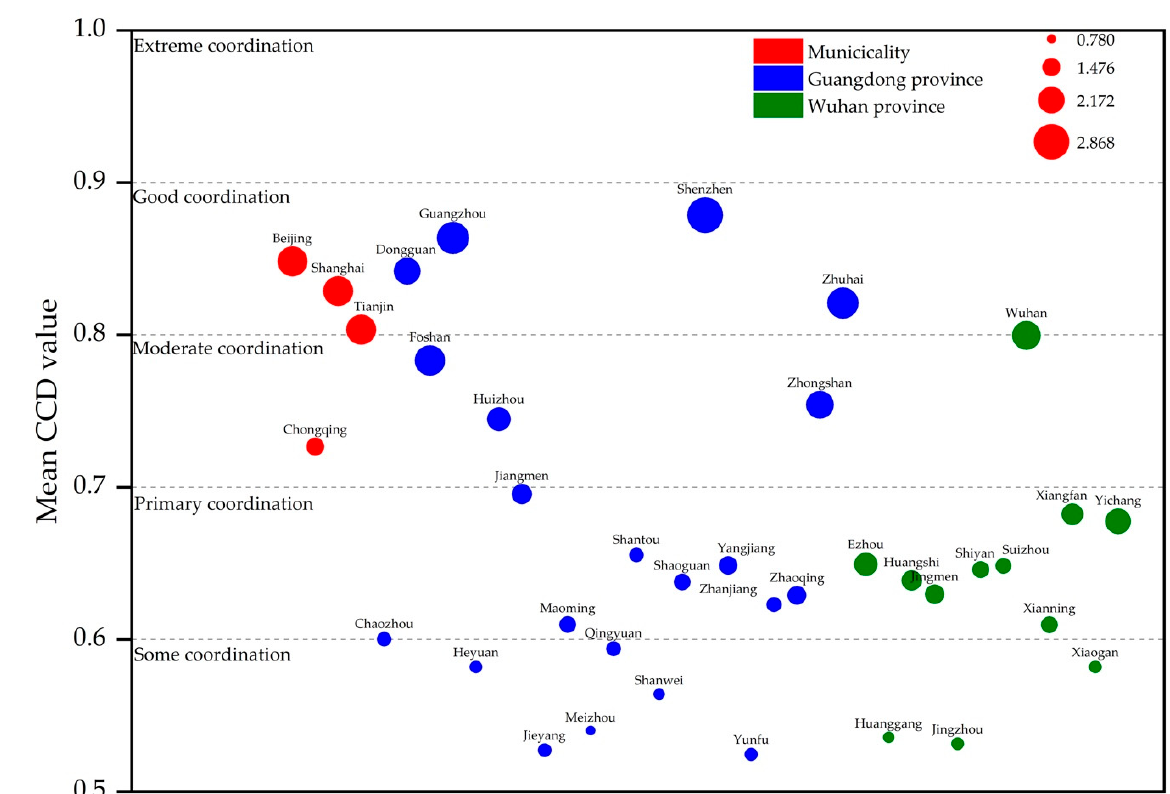
Figure 2. CCD levels of the pilot cities.